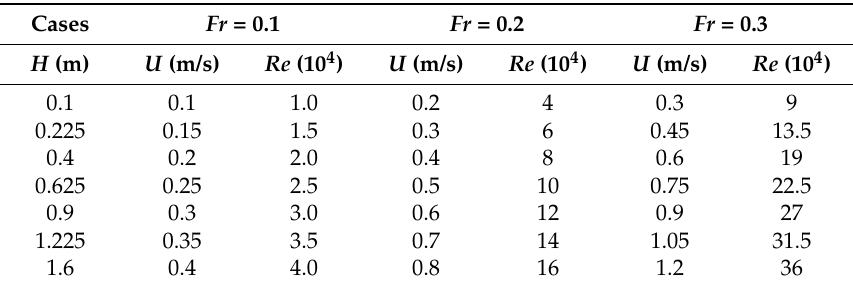
Table 2. The parameters of the study for hydrodynamic tests.